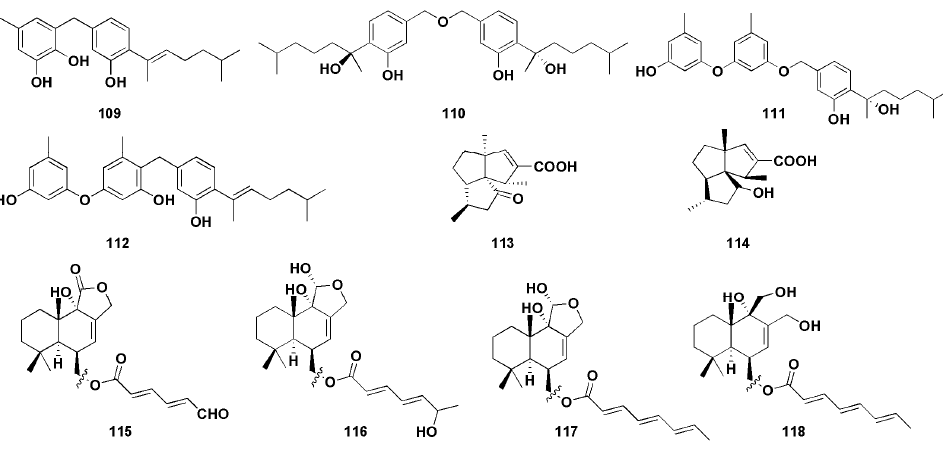
Figure 8. Chemical structures of enzymatic inhibitory compounds ( 109 – 118 ). α -Glucosidase is a membrane-bound enzyme present in the small intestinal epithe- catalyzing the hydrolysis of oligosaccharides into absorbable glucose. α -Glucosidase in-